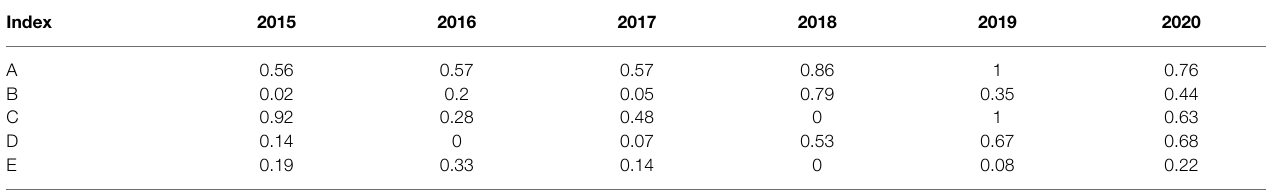
TABLE 2 | Dimensionless processing results of evaluation index